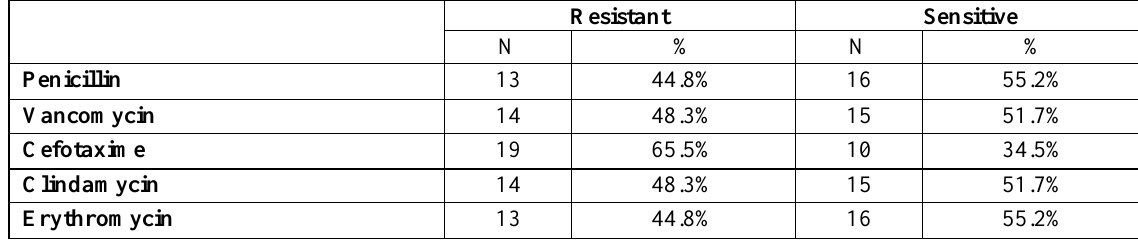
Table 3. The results of antibiotic susceptibility of the positive GBS isolates by disc diffusion method.